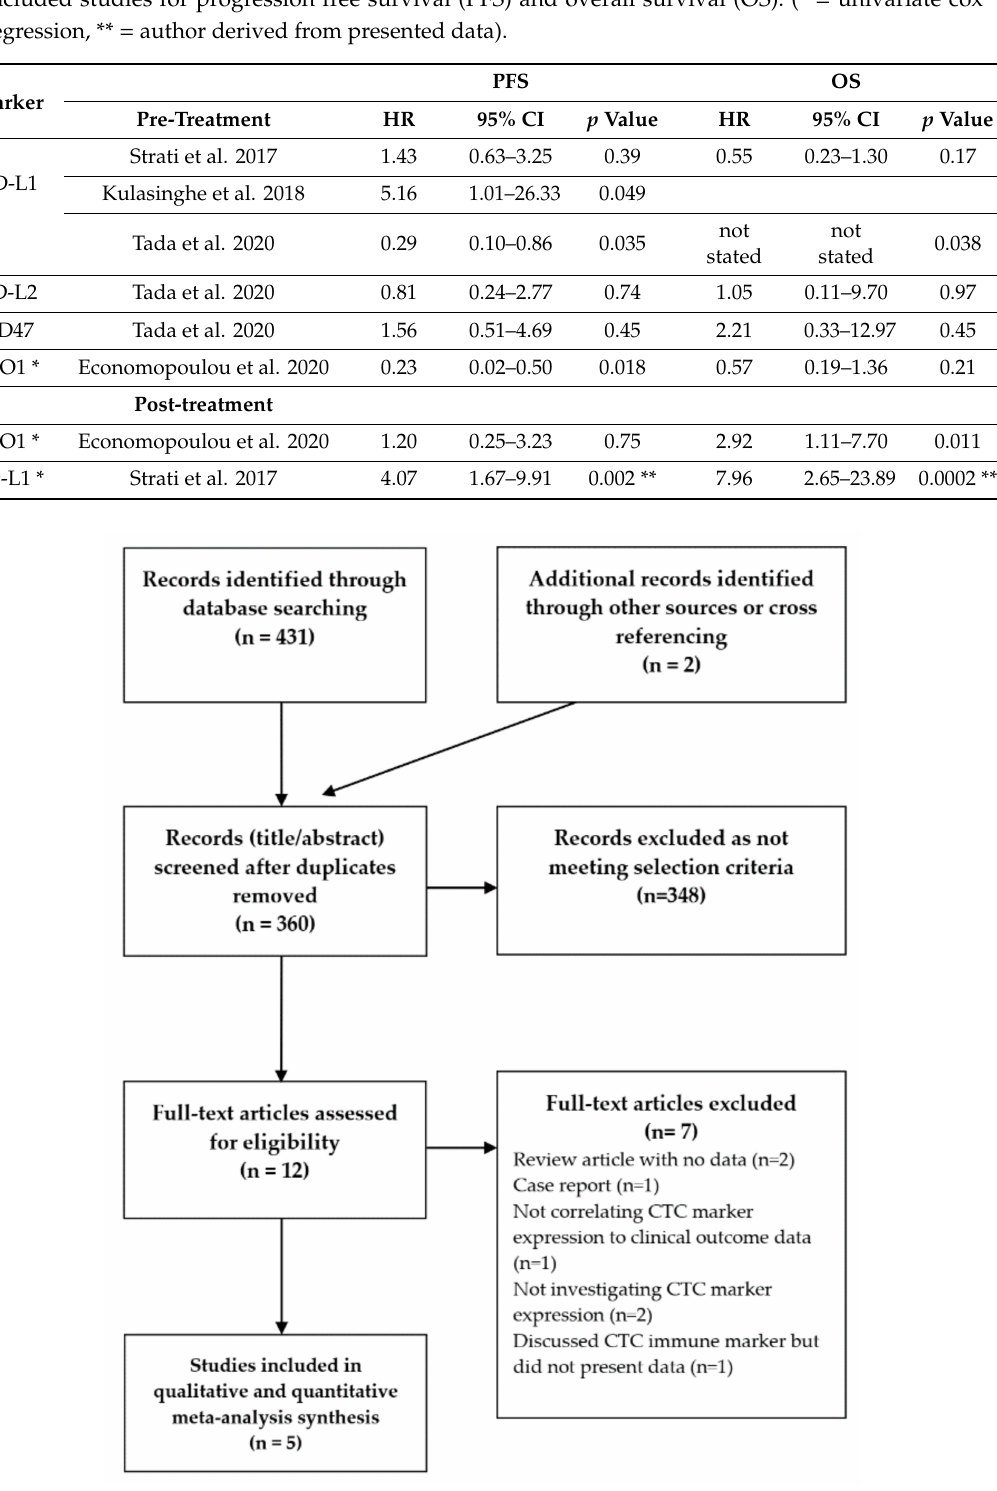
Figure 1. Study selection flowchart. CTC: circulating tumour